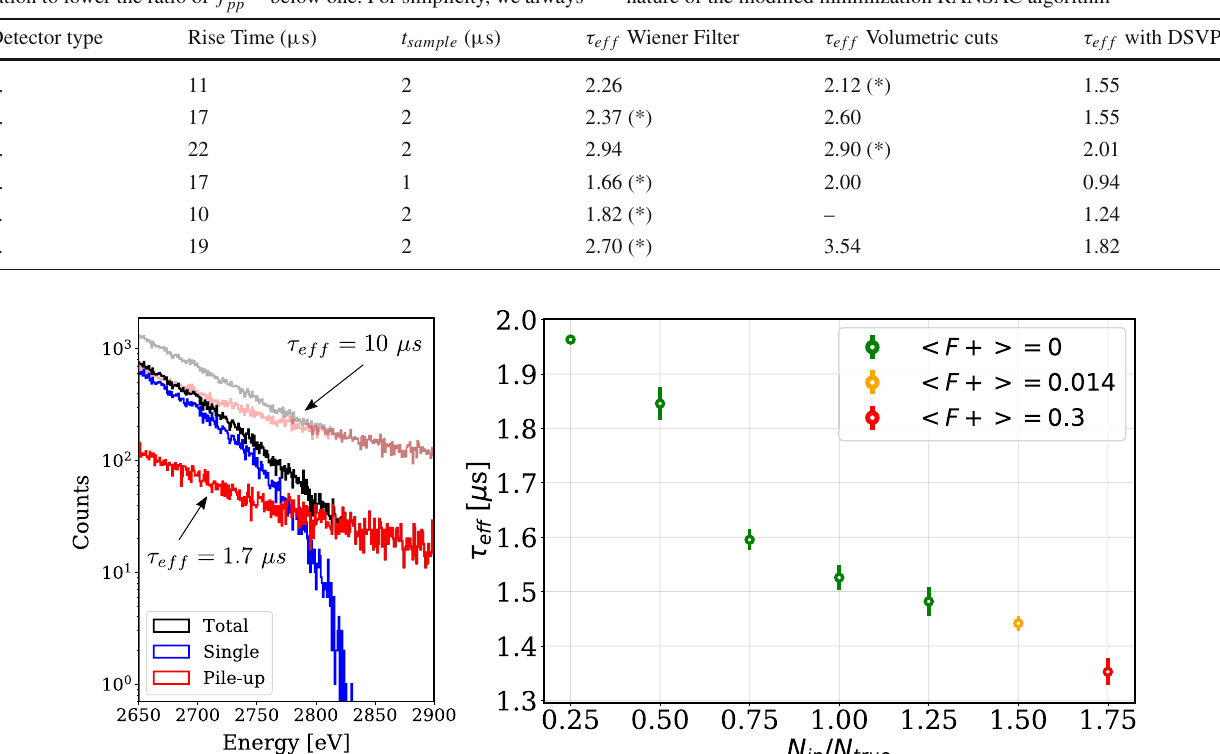
average percentage of false positive F + from the input parameter N B ( N in ), which is normalized by the number of pile-up pulses present in the ROI ( N true )